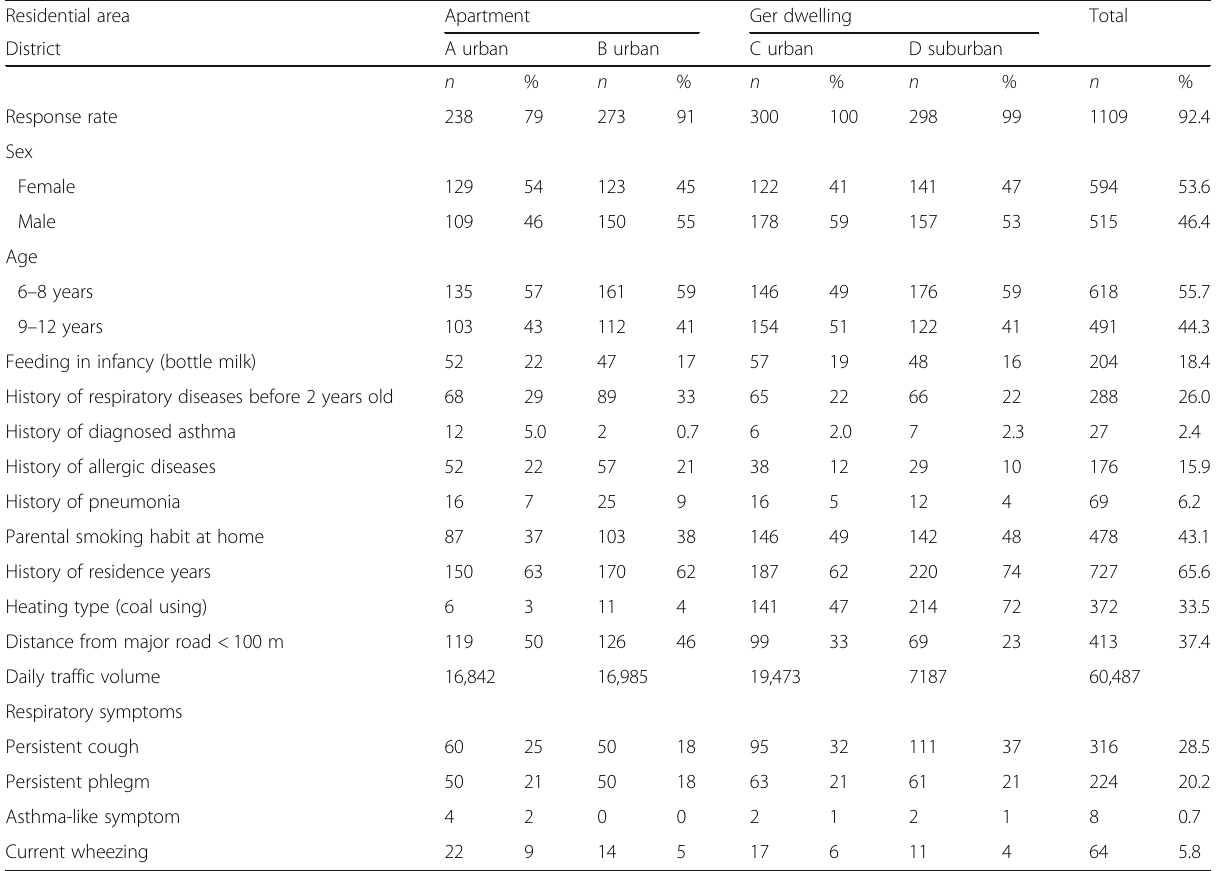
Table 3 Descriptive characteristics of the subjects and the prevalence of respiratory symptoms based on the questionnaire Residential area